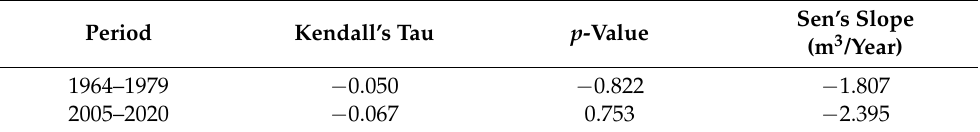
Figure 11. Effective rainfall and trend line in black colour: ( a ) 1964–1979 ( b ) 2005–2020. Table 5. Mann–Kendall and Sen’s slope test results for effective precipitation